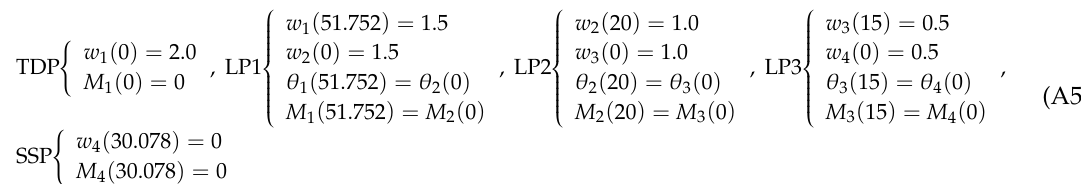
(c) Figure A3. Analysis results of the segmental pipeline model in the vertical plane: ( a ) deflections; ( b ) bending moments; ( c ) shear forces.